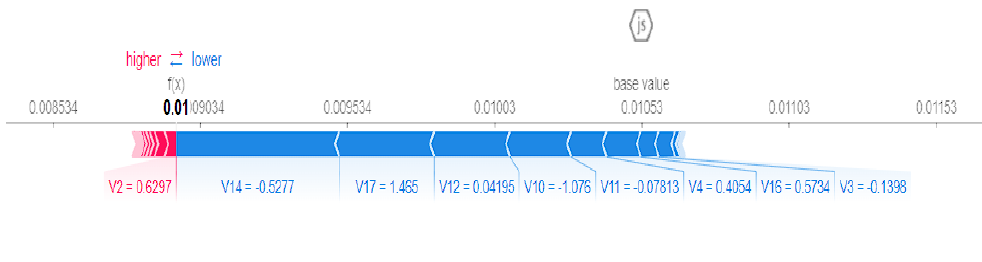
Figure 6. Force SHAP